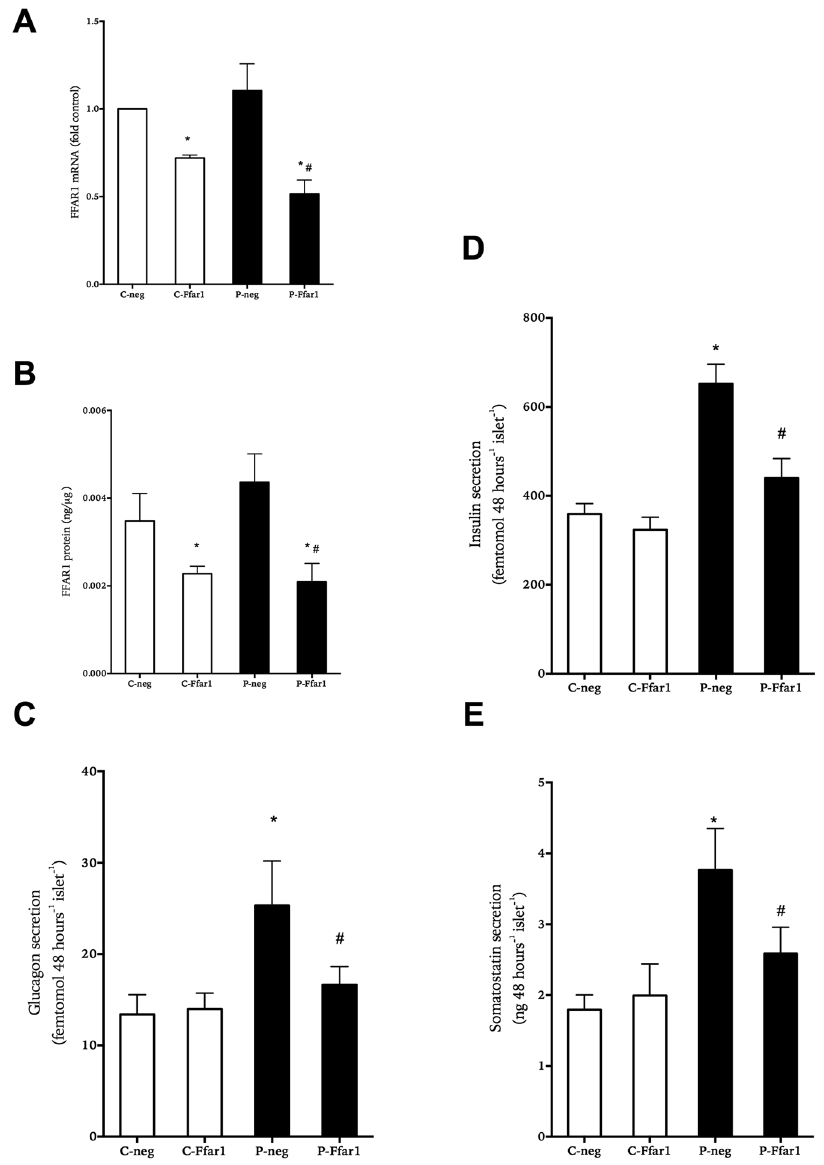
Figure 2. Effect of decreasing FFAR1 expression on accumulated hormone secretion from human islets cultured at 5.6 mM glucose in the absence (white bars) or presence of 0.5 mM palmitate (black bars) for 1 day. Relative FFAR1 mRNA levels (panel A) and total FFAR1 protein (panel B) at the end of culture as compared to non-mammalian target shRNA (neg) or shRNA targeting Ffar1 (Ffar1) treatment. Accumulated secretion of glucagon (panel C), insulin (panel D) and somatostatin (panel E) is shown. Results show mean ± SEM and are from n = 3–5 donor experiments. * P < 0.05 vs. control-neg, # p < 0.05 vs.